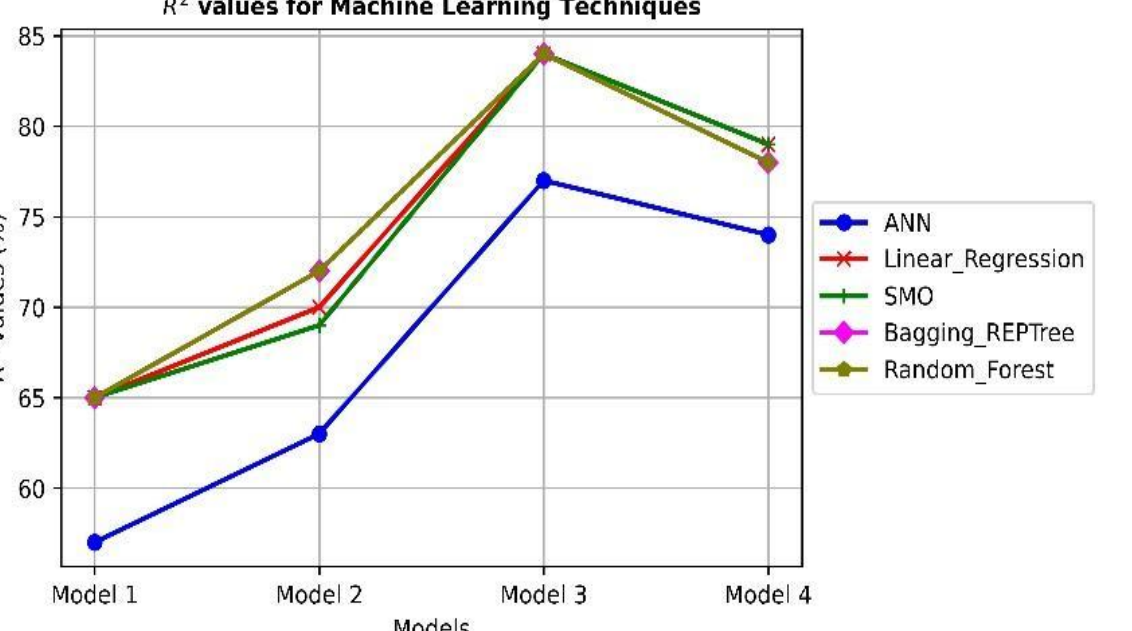
Figure 2. The results of using ML techniques on the SANAD App dataset R 2 .